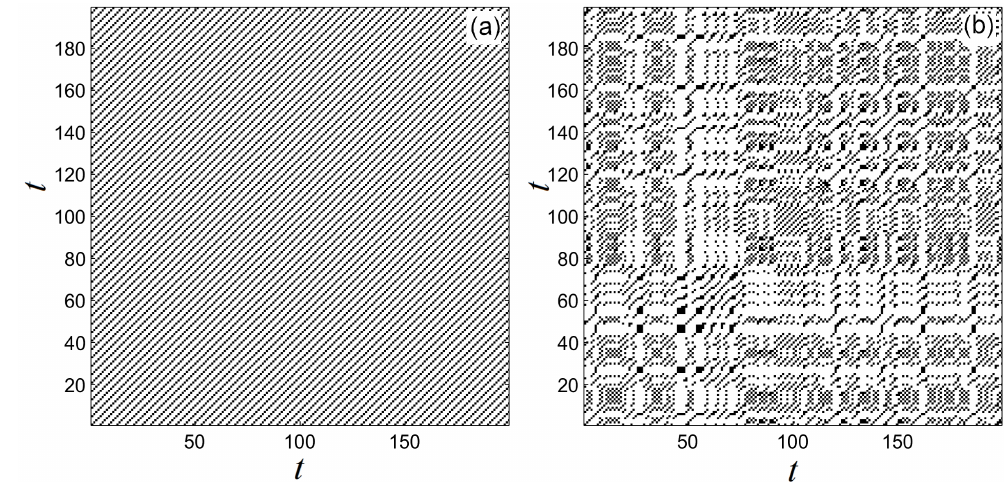
Figure A2. The recurrence plot applied to the logistic map x n + 1 = rx n ( 1 − x n ) ; ( a ) the recurrence plot of the logistic map with r = 3.4 and threshold (cid:101) = 0.05; ( b ) the recurrence plot of the logistic map with r = 4 and threshold (cid:101) =